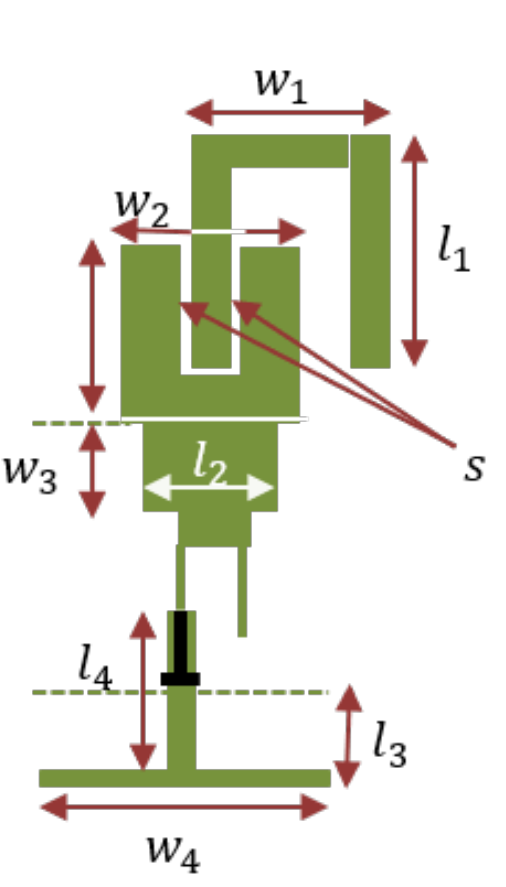
Fig. 13. The proposed integration board of the BPF for a dipole antenna where; l 1 = 6.85 mm , l 2 = 16.8 mm , l 3 = 7.68 mm , l 4 = 11.8 mm , w 1 = 4.65 mm , w 2 = 3.8 mm , w 3 = 5.2 mm , w 4 = 42.1 mm and s = 0.18 mm ,